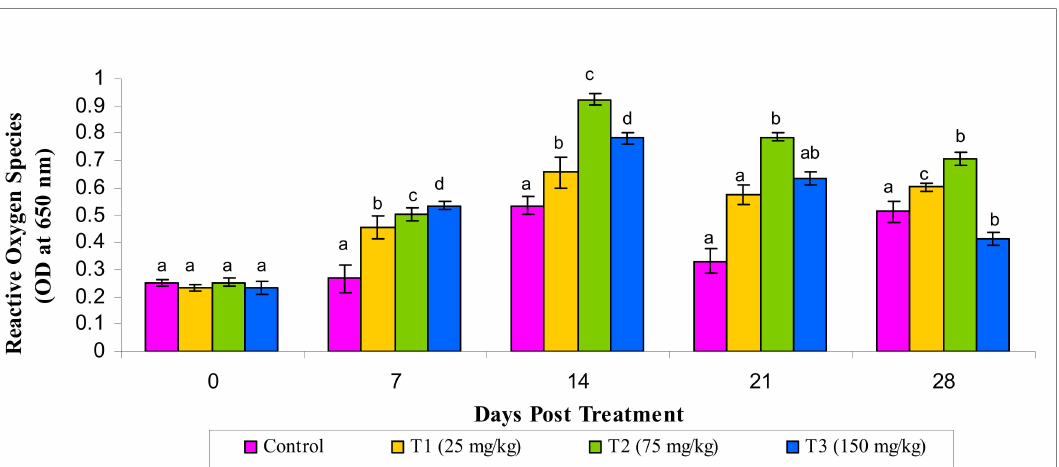
Figure 6. E ff ect of methanol extract of Chaetomorpha antennina on the Reactive Oxygen Species production by peripheral blood leukocytes in Labeo rohita (values are mean ± SE). a,b,c,d Mean values with di ff erent superscripts considered as statistically di ff erent( p < 0.05); n = 6 for each treatment group.